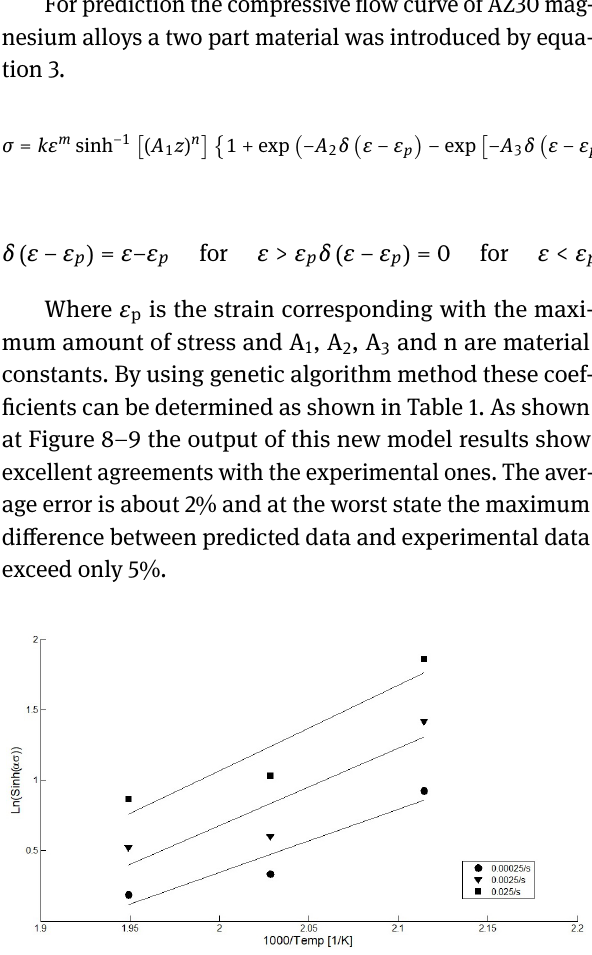
For prediction the compressive flow curve of AZ30 mag- nesium alloys a two part material was introduced by equa- tion 3.